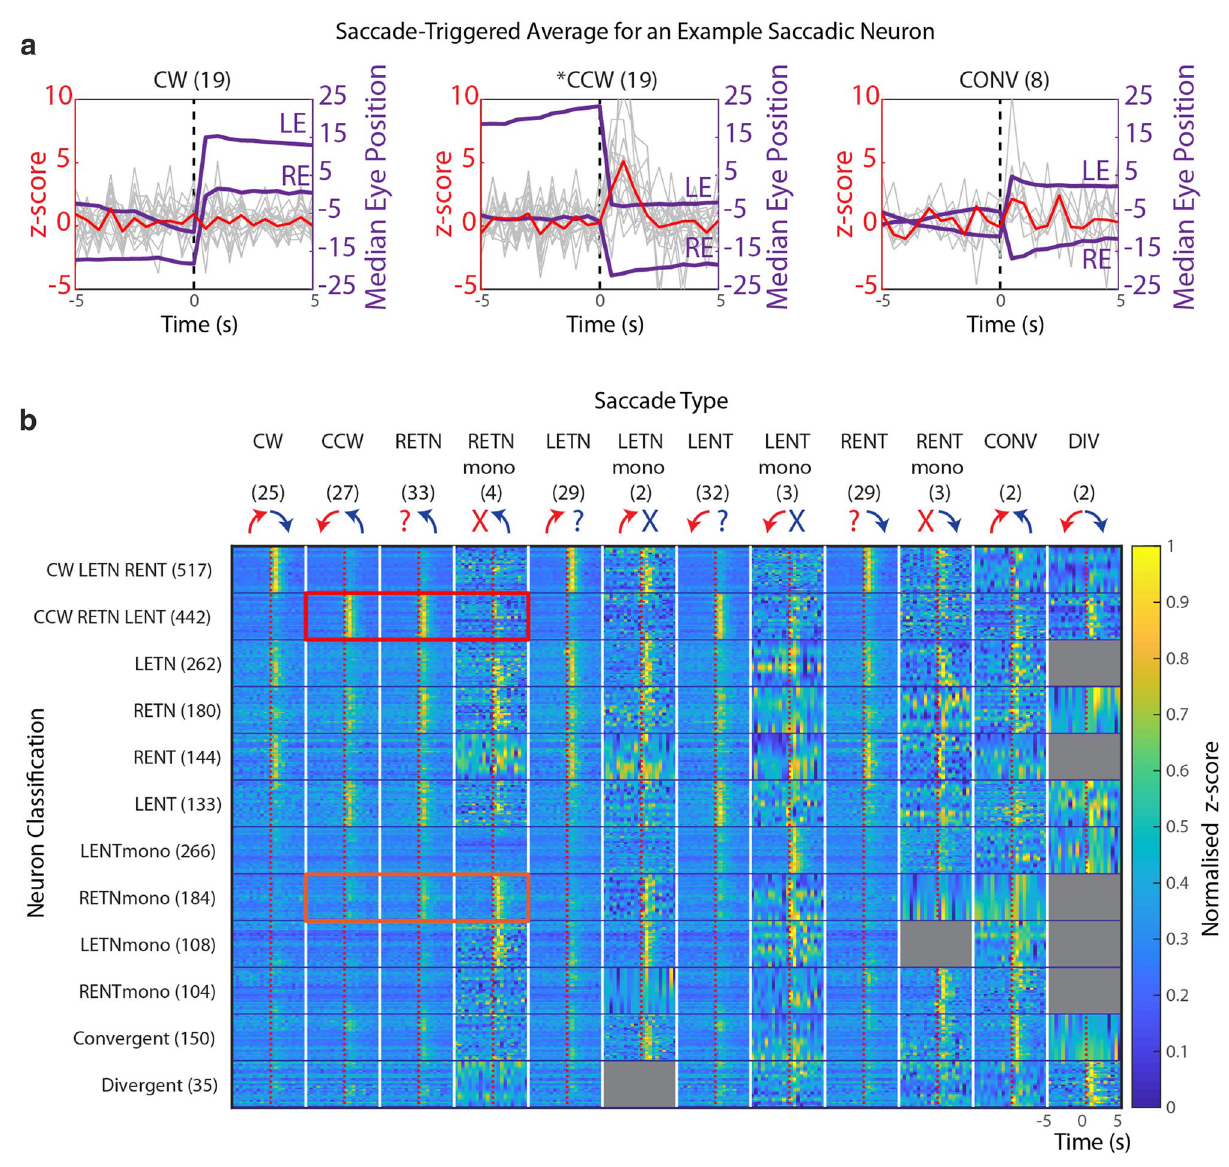
Figure 4. Peri-saccadic activity of different saccade-associated neuron types. ( a ) Saccade-triggered average (STA) of neural activity (calcium signal z-score, red trace). The example neuron was significantly active during or directly after CCW saccades (middle) but inactive during CW or CONV saccades (left and right plots), the full STA for this neuron is shown in Fig. S2. The numbers in brackets indicate the number of saccades in this recording. Median eye positions are plotted in purple. Z-score traces for individual saccades are plotted in grey. The dotted line represents the saccade time point. Saccade-associated neurons were first identified via regressor based analysis, and then classified based on a ranksum test comparing activity in the 9 pre-saccadic sampled time points with that of the saccadic, and two immediate post-saccadic timepoints. Resulting values were Bonferroni corrected (factor of 3). ( b ) Raster plot of neuronal STA activity (normalized per neuron) across different saccades types (columns) and for different neuron types (rows). Neurons were classified according to the STA significance analysis (see “Methods”) and the numbers of identified neurons for each classified neuron type are indicated in brackets. Note that the conjugate CCW-RETN-LENT population is not significantly active during monocular RETN saccades (red rectangle), and the RETN mono population is not significantly active during conjugate CCW saccades (orange rectangle). Within a functional neuron type, each line represents the activity of a single cell. Since certain neuron types occurred less frequently than others, the y-axis has been compressed or stretched to fill each of the squares for visualization purposes. X-axis labels indicate the saccade type, and mean number of saccades of that type occurring per recording. Grey squares correspond to neuron and saccade type combinations for which we had an insufficient amount of data (less than two neurons in the population with 6 saccades of that